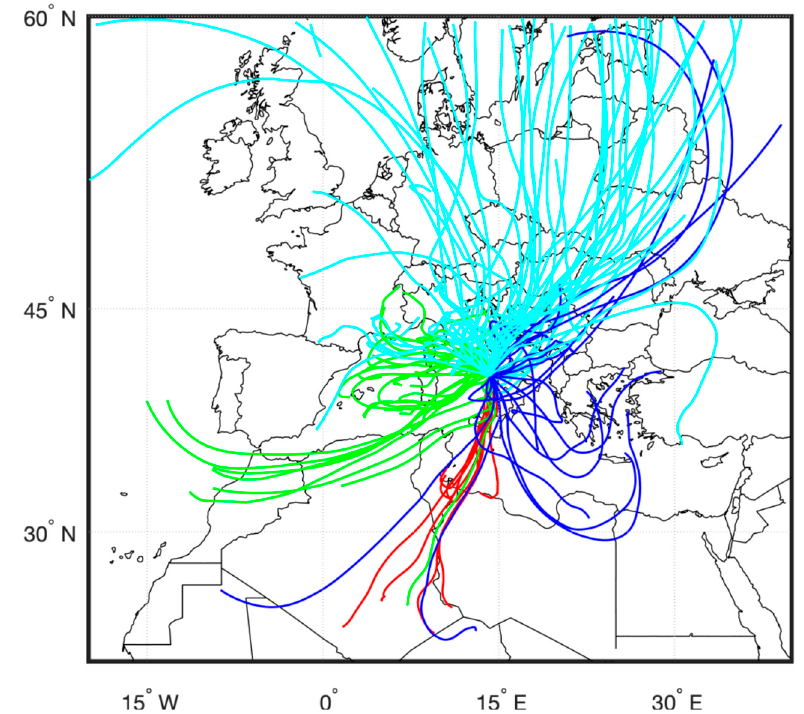
Figure 2. Back-trajectories relative to the days of interest, calculated with the HYSPLIT model. Average wind directions and wind speeds during the 24 h sampling duration are calculated as vector average of the hourly records over the whole sampling time, according to the method reported by Grange et al.